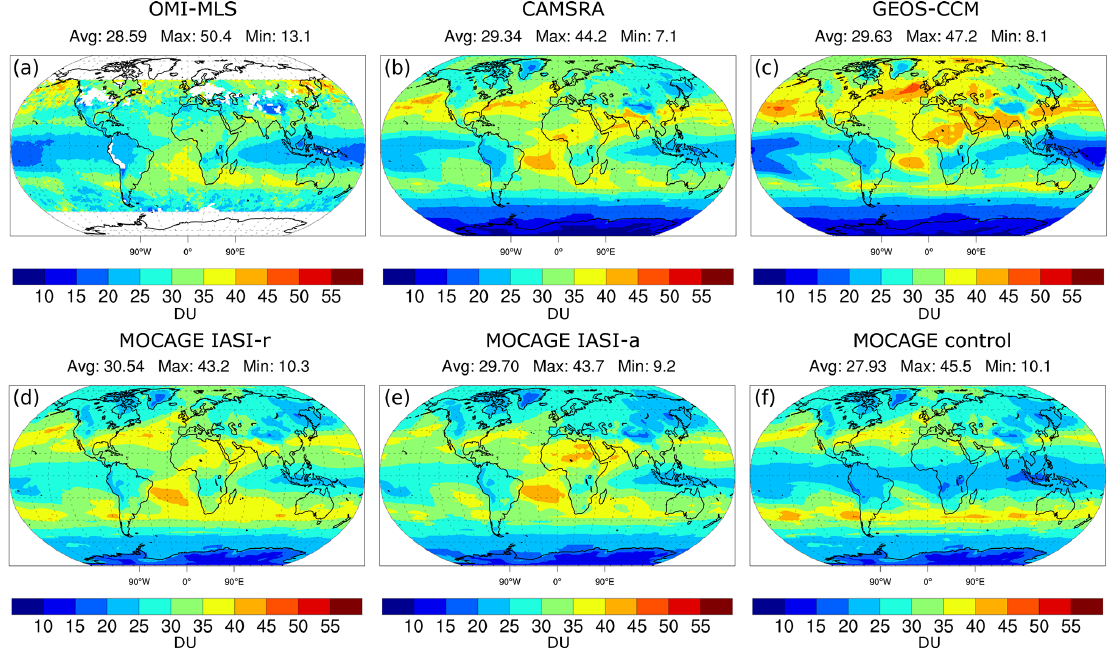
Figure 4. Tropospheric ozone column averaged over December–January–February 2010 from OMI-MLS retrievals (a) , CAMSRA reanaly- sis (b) , GEOS-CCM simulation (c) , IASI-r reanalysis (d) , IASI-a reanalysis (e) , and the MOCAGE control simulation (f) . Mean, minimum, and maximum values of ozone (in DU) are depicted over each plot.